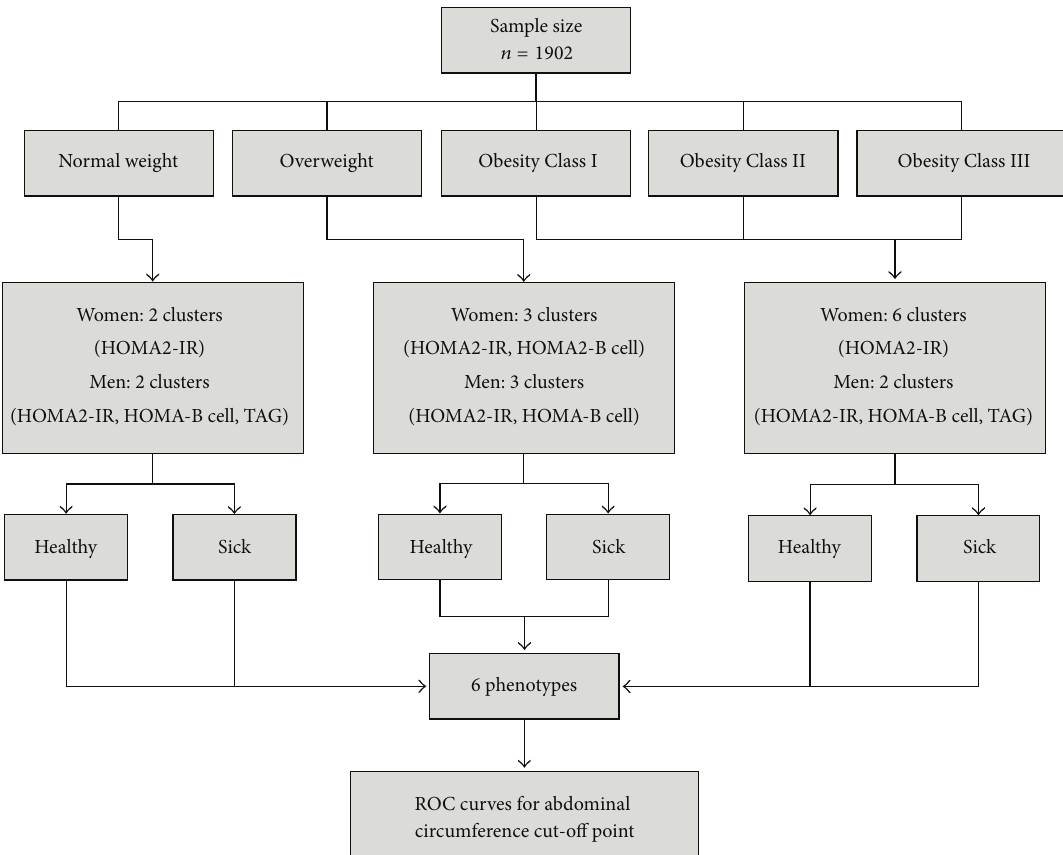
Figure 1: Diagramshowing the two-stage clustering method to properly categorize the subjects into healthy and sick groups according to the selected